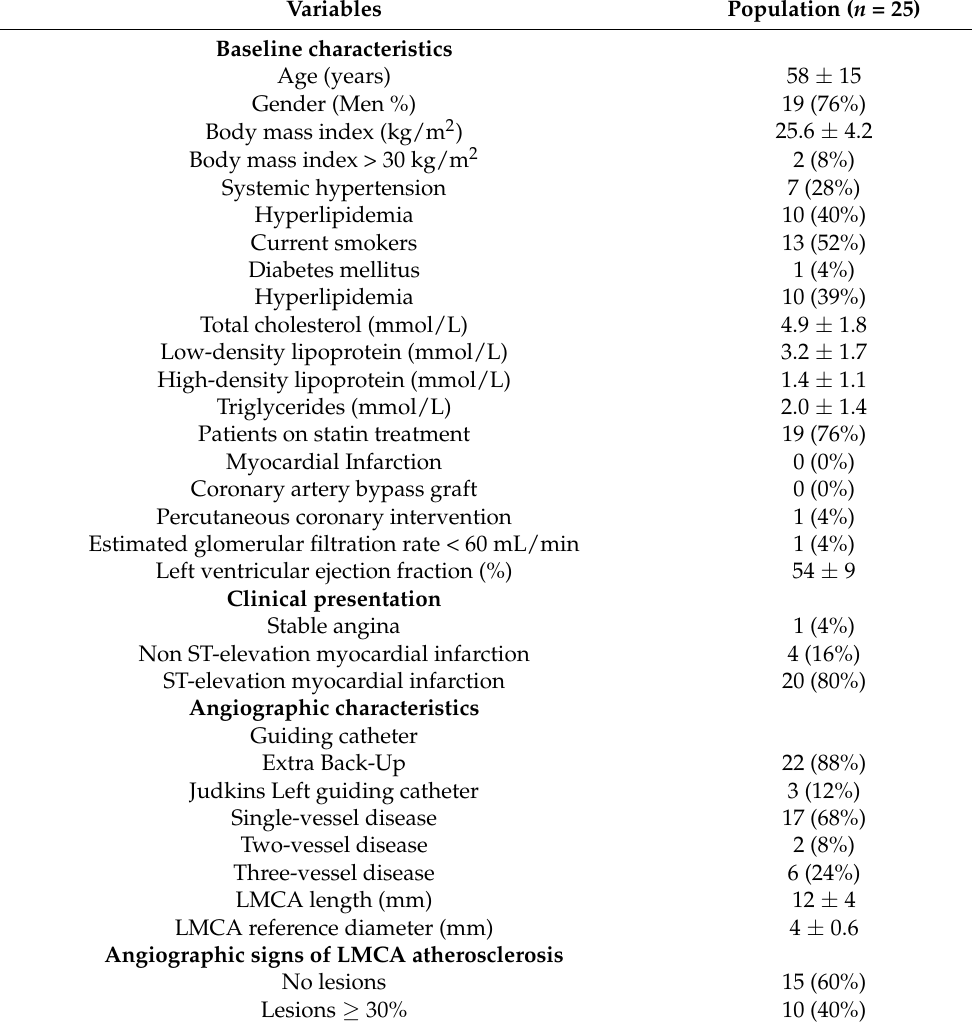
Table 1. Demographic and angiographic characteristics of the population